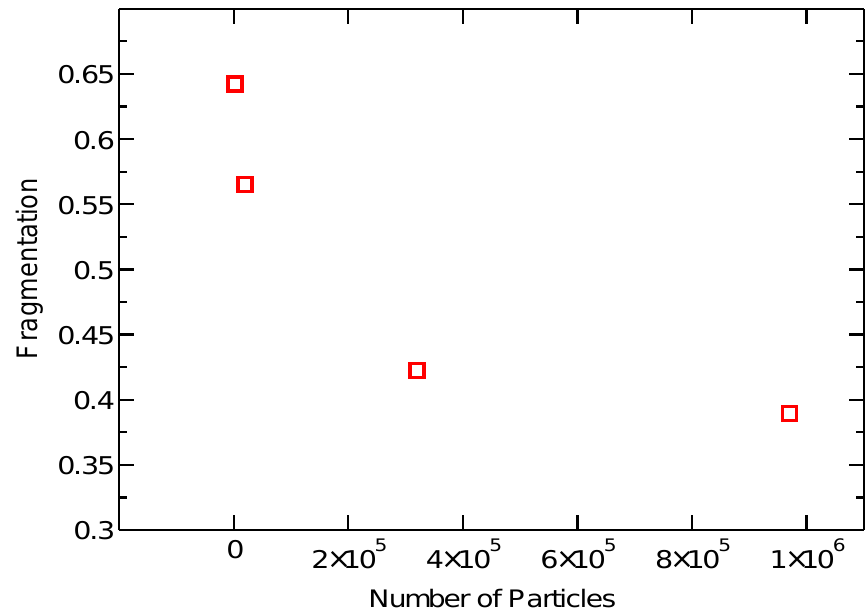
Figure 5. Fragmentation in debris clouds simulated with a varying number of particles shows